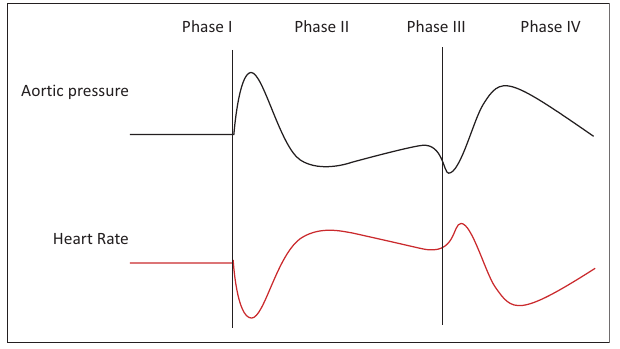
FIGURE 2: The physiology of the Valsalva